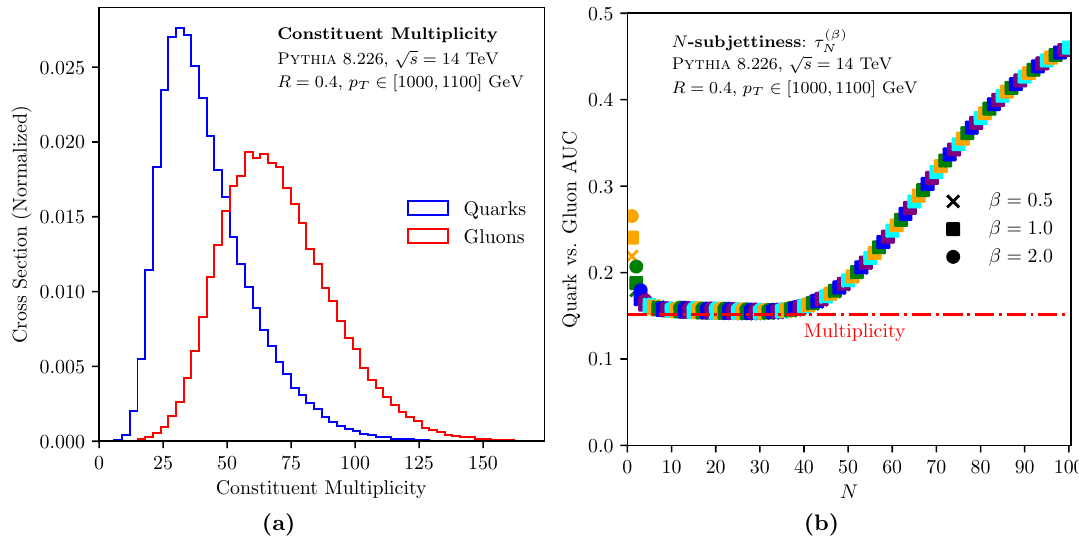
Figure 9. The (a) distribution of constituent multiplicity in quark and gluon jets and (b) the AUCs for N -subjettiness observables for N up to 100 and (cid:12) observables quickly converge to the AUC of multiplicity for small N and then begin to diverge from multiplicity once N is comparable to and larger than the mean quark multiplicity of about N & 40. This is consistent with expectations from section